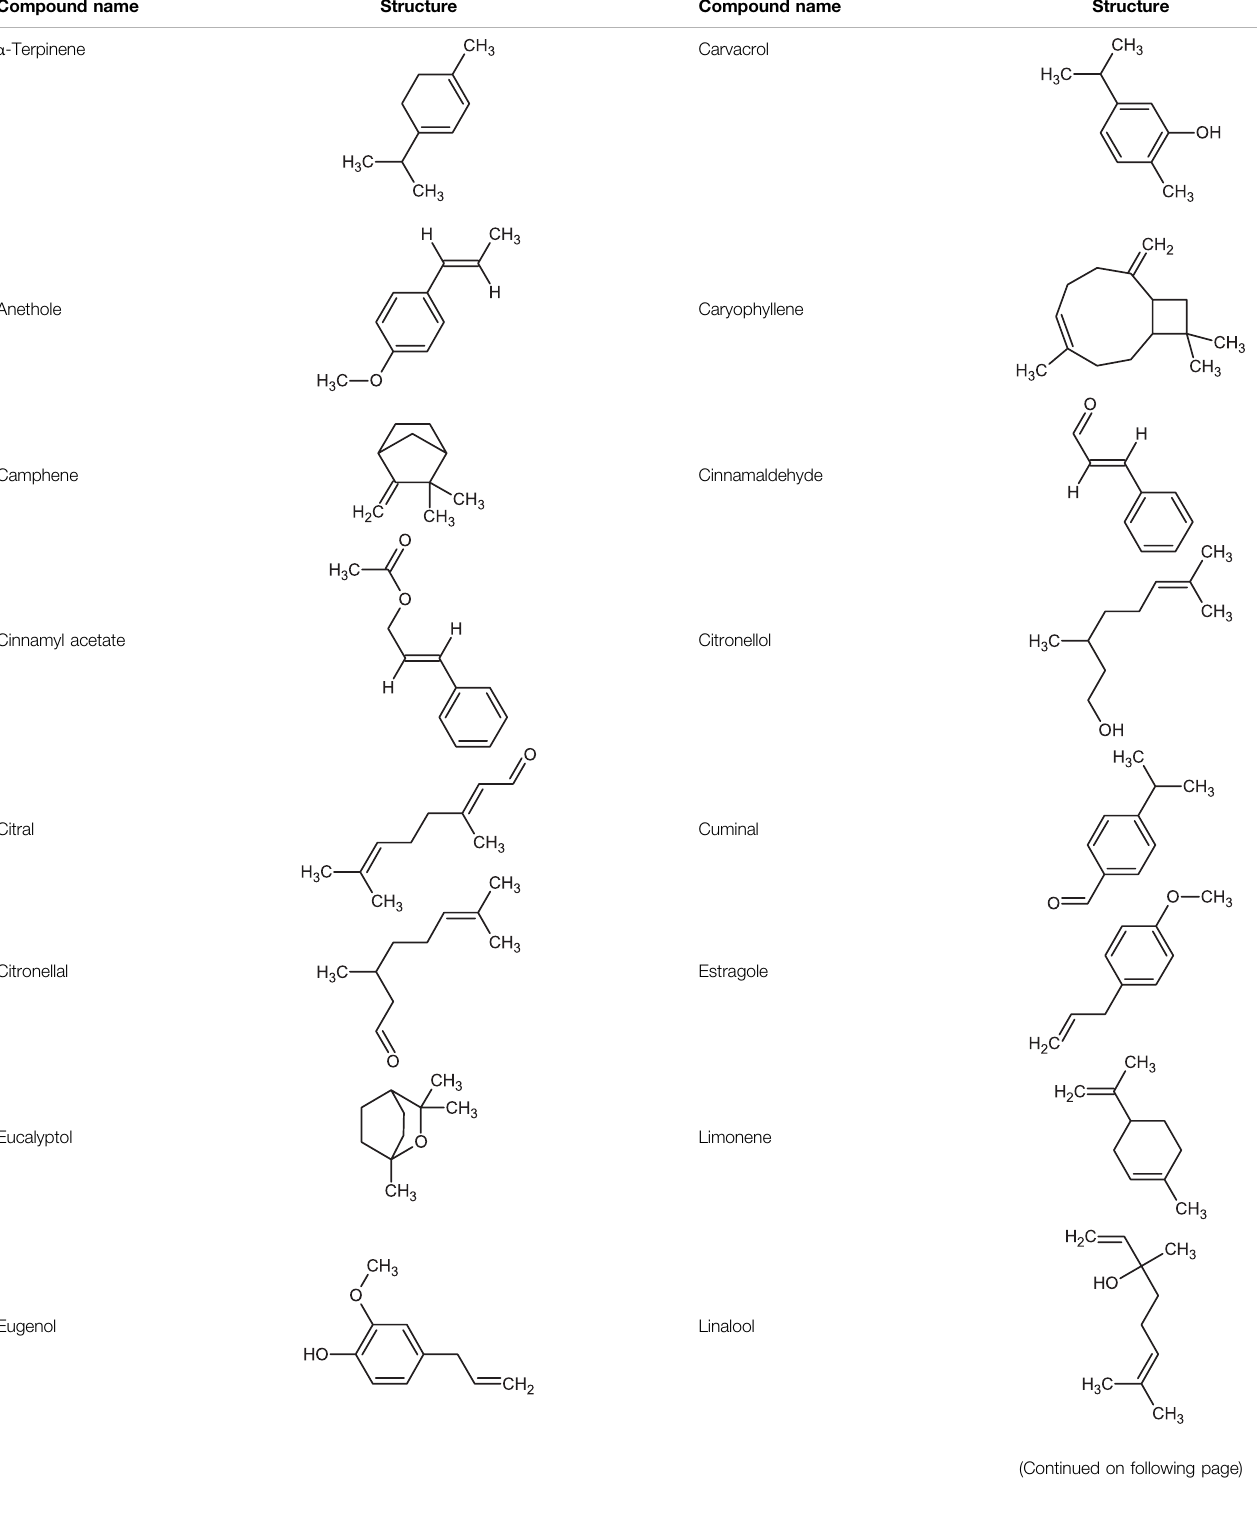
TABLE 1 | 2D structures of the ligands (EO